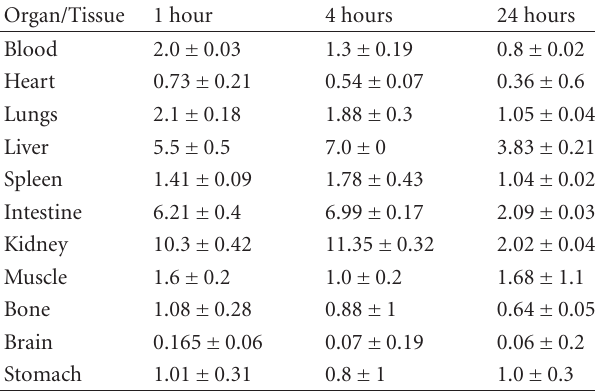
Table 2: Biodistribution data of 99m Tc-EMB in Balb/c mice. The mice were administered 40KBq of 99m Tc-INH, and the radioactivity in di ff erent organs was measured at 1hr, 4hrs, and 24hrs, respectively. each value is the mean ± SD of three mice and expressed as percentage administered dose per gram organ.